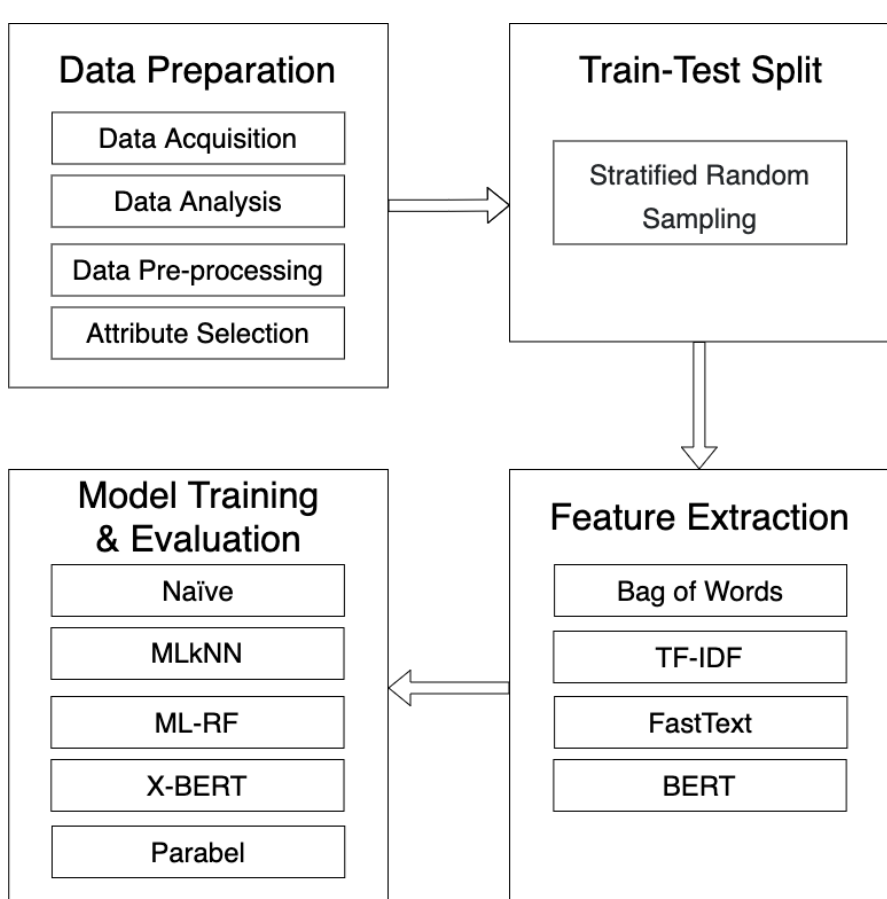
Figure 1. The diagram description of our work. Each box represents a specific phase of the project